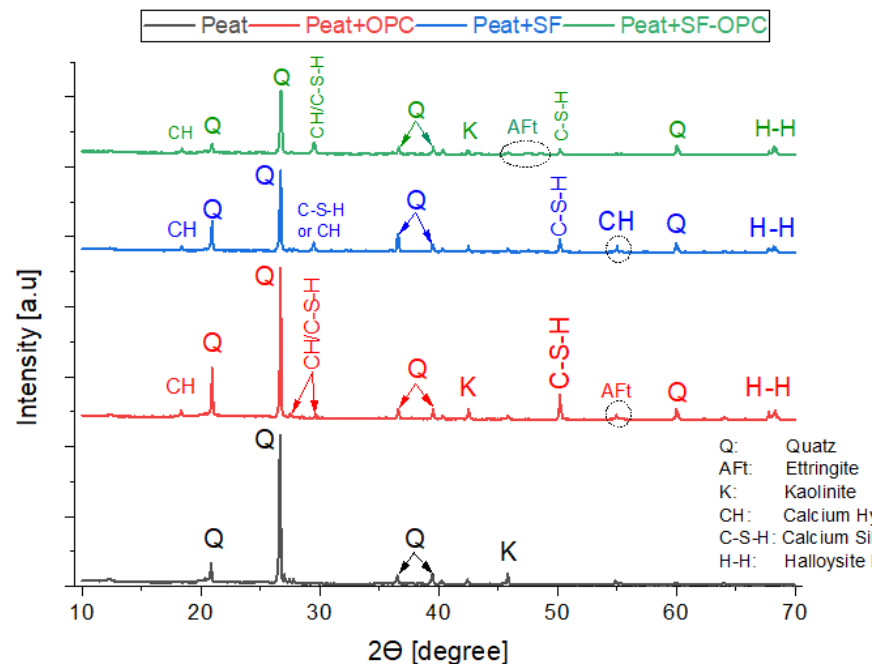
Figure 6. XRD analysis of Peat only, Peat + OPC, Peat + SF, and Peat + OPC + SF.